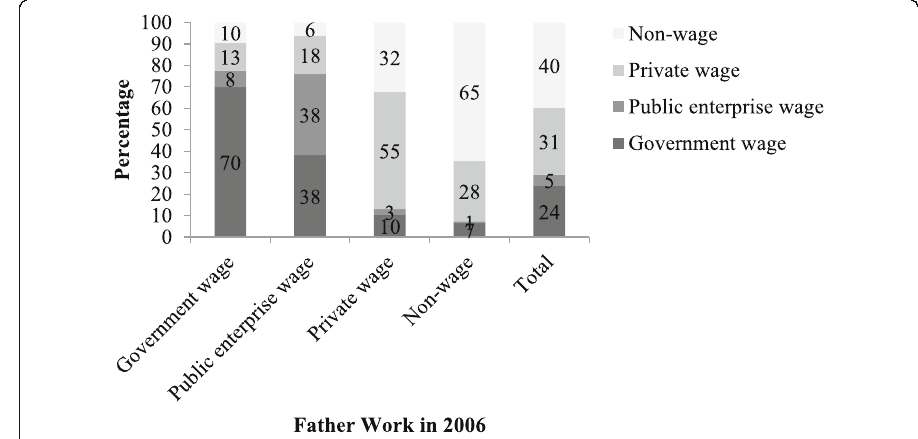
Fig. 2 Father ’ s sector of work and employment status when individual was age 15, as reported in 2006 versus 2012, father not in household in 2006 or 2012, aged 30 – 54 in 2006 (percentage). Source: Authors ’ calculations based on ELMPS 2006 and ELMPS